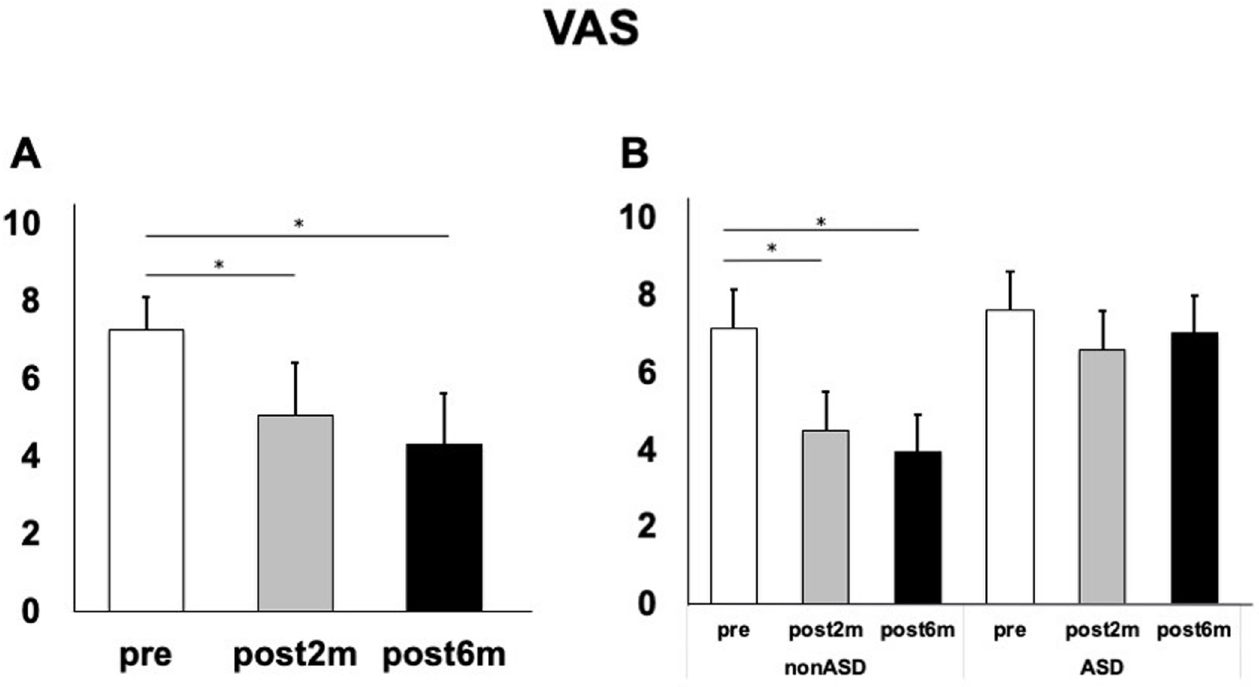
Fig 2. Low back pain visual analog scale before and after the intervention. A) Changes in low back pain in all patients. B) Changes in low back pain in the adult spinal deformity (ASD) and non-ASD groups, respectively.